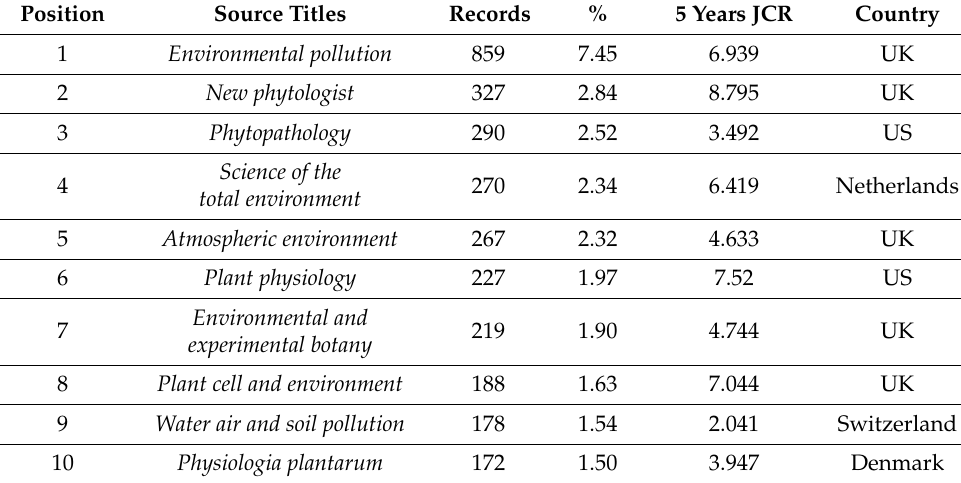
Table 2. Distribution of publications by source.